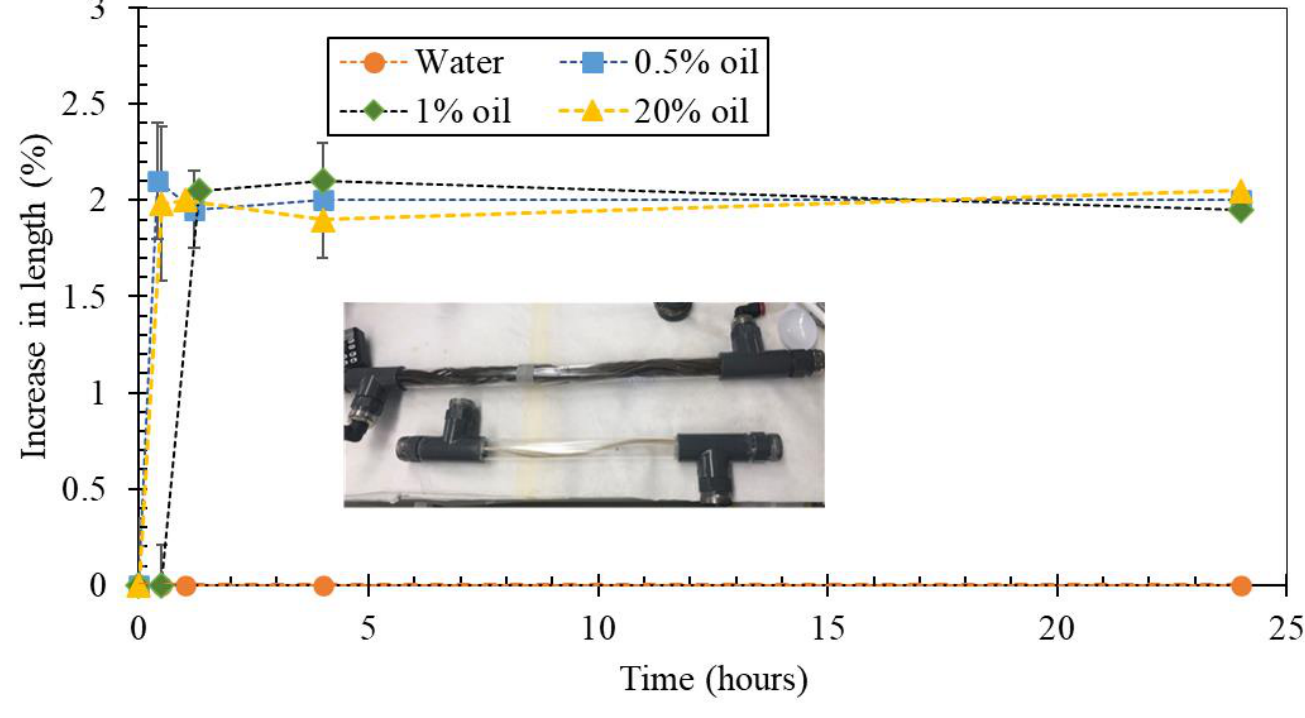
Figure 7. Increase in fiber length when exposed to the solutions containing different oil fractions